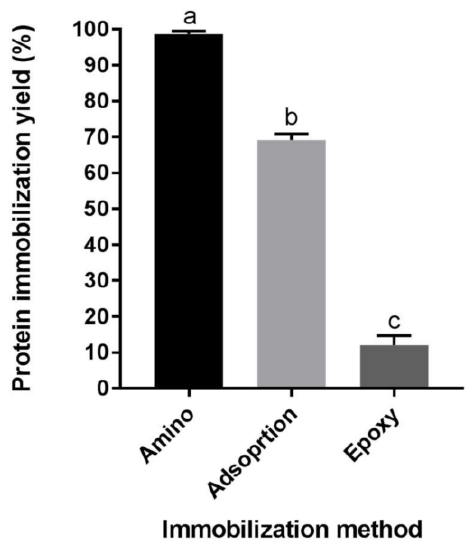
Figure 1. Protein immobilization yield for amino, adsorption, and epoxy immobilization methods, measured fluorometrically by Qubit Protein Assay Kit. Error bars represent one standard deviation and means followed by different letters (a, b, and c) are statistically different at p < 0.05.